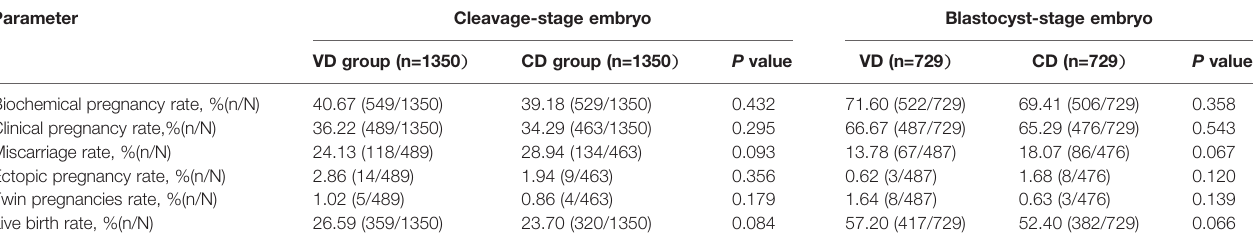
TABLE 2 | Pregnancy outcomes of patients with different previous delivery modes.